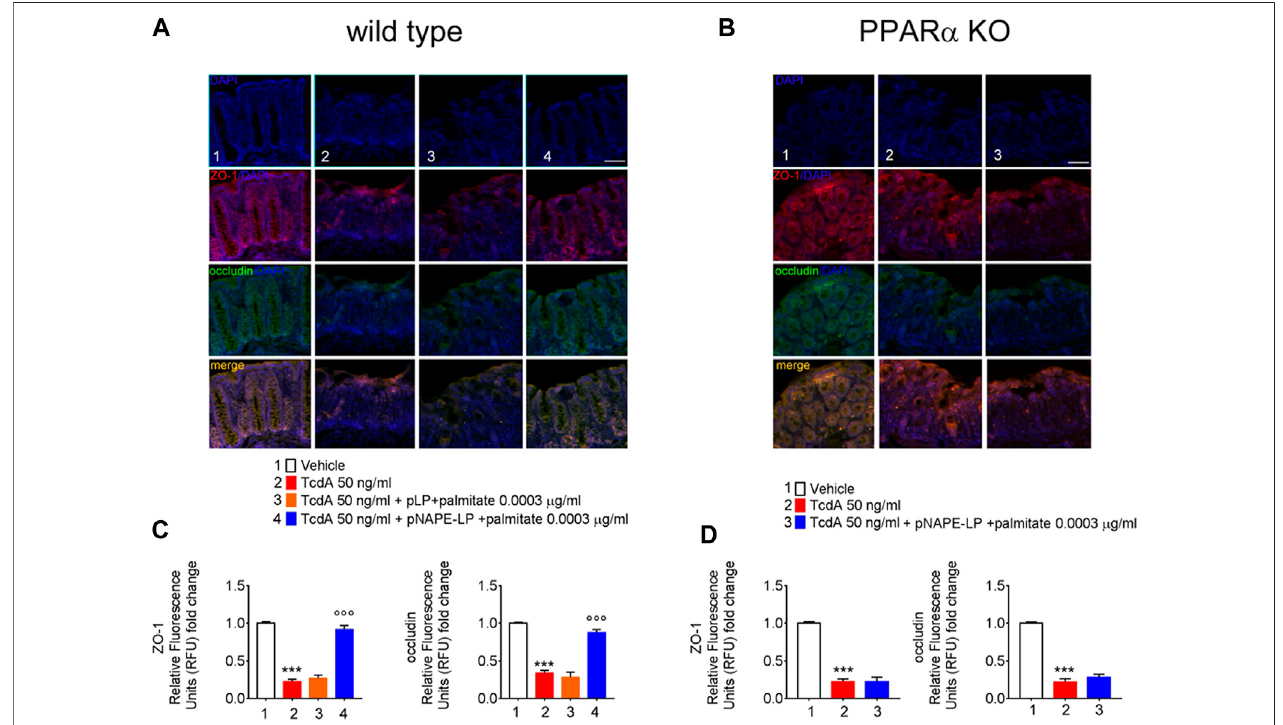
FIGURE 5 | PEA released from pNAPE-LP and ultralow palmitate co-administration restores TcdA-induced colon-barrier disruption, through the upregulation of tightjunctionproteinsZO-1andoccludin.Representativeimmuno fl uorescenceimagesshowingtheexpressionofZO-1(red),occludin(green),andtheirmerge(yellow)in both wild type (A) and PPAR α KO (B) mice colonic specimen with their respective quanti fi cation (C, D) showing the PPAR α -dependent protective effects of pNAPE-LP combined to palmitate (0.0003 μ g/kg) co-administration. Nuclei were also investigated using DAPI staining. Results are expressed as mean ± SEM of n (cid:2) 5 experiments performed in triplicate. *** p < 0.001 vs. vehicle; ooo p < 0.001 vs. DSS-treated mice. Scale bar (cid:2) 100 μ m; magni fi cation 10 × . Scale bar: 100 μ